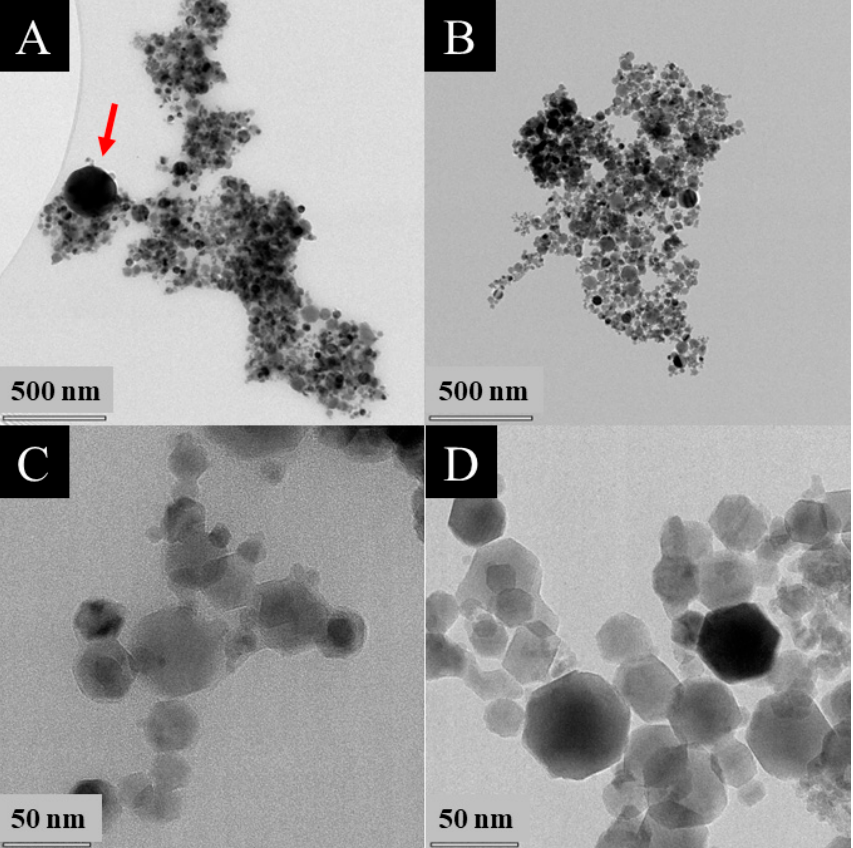
Figure 2. TEM images ( A – D ) at different magnifications for Fe 2 O 3 nanoparticles: ( A , C ) before and ( B , D ) after HEBM. Arrow shows large particle in as-received Fe 2 O 3